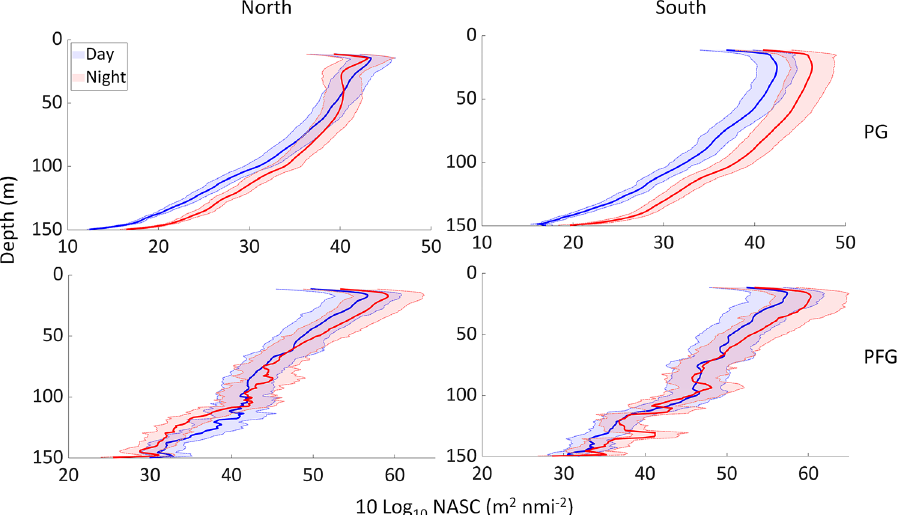
Figure 6. Effect of diel vertical migration (DVM) on the pelagic abundance within the water column [expressed in Nautical Area Scattering Coefficient (m 2 nmi m −2 )] on the trends for the plankton group (PG) and pelagic fish group (PFG) in the areas north (left) and south of Cap Blanc (right) in the Canary Current Large Marine Ecosystem. Shaded areas represent the standard